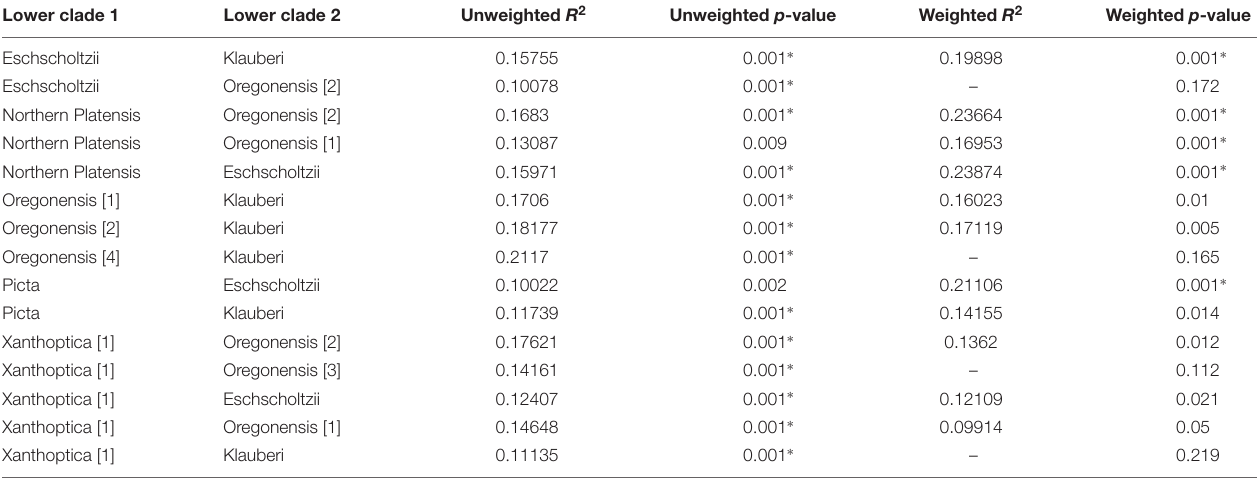
TABLE 2 | Summary of R 2 and p -values of adonis analyses from Ensatina lower clade group pairwise comparisons of weighted and unweighted Unifrac distances. Lower clade